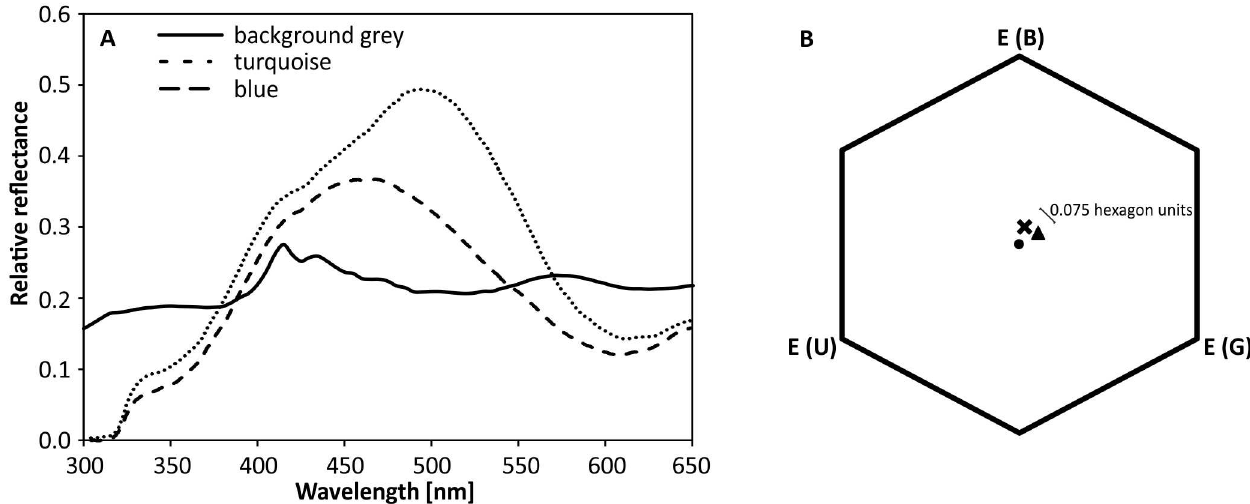
Fig 1. Color stimuli qualities. A Spectral reflectance of stimuli. B Loci of color stimuli in a color hexagon. The cross marks the location of the blue stimulus, while the triangle indicatesthe location of the turquoise stimulus. The hexagon’scenter is indicatedby the dot. See text for details.